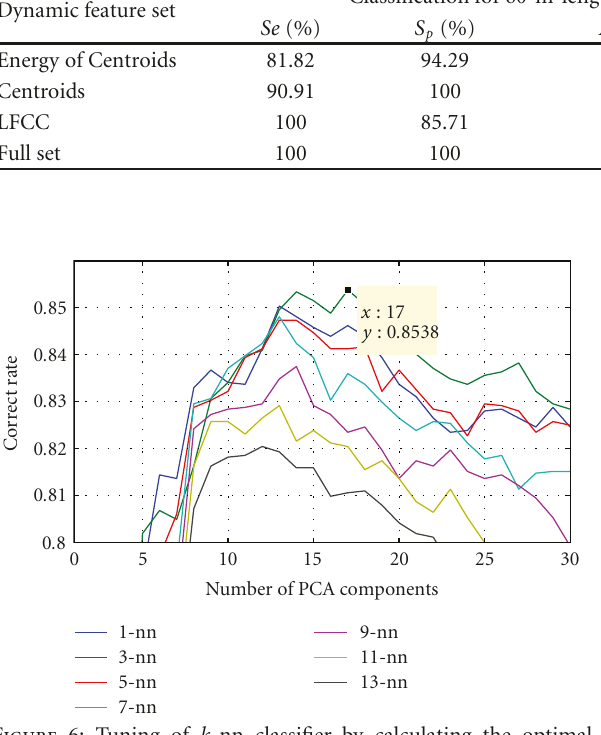
Figure 6: Tuning of k -nn classifier by calculating the optimal number of neighbors in terms of accuracy performance.